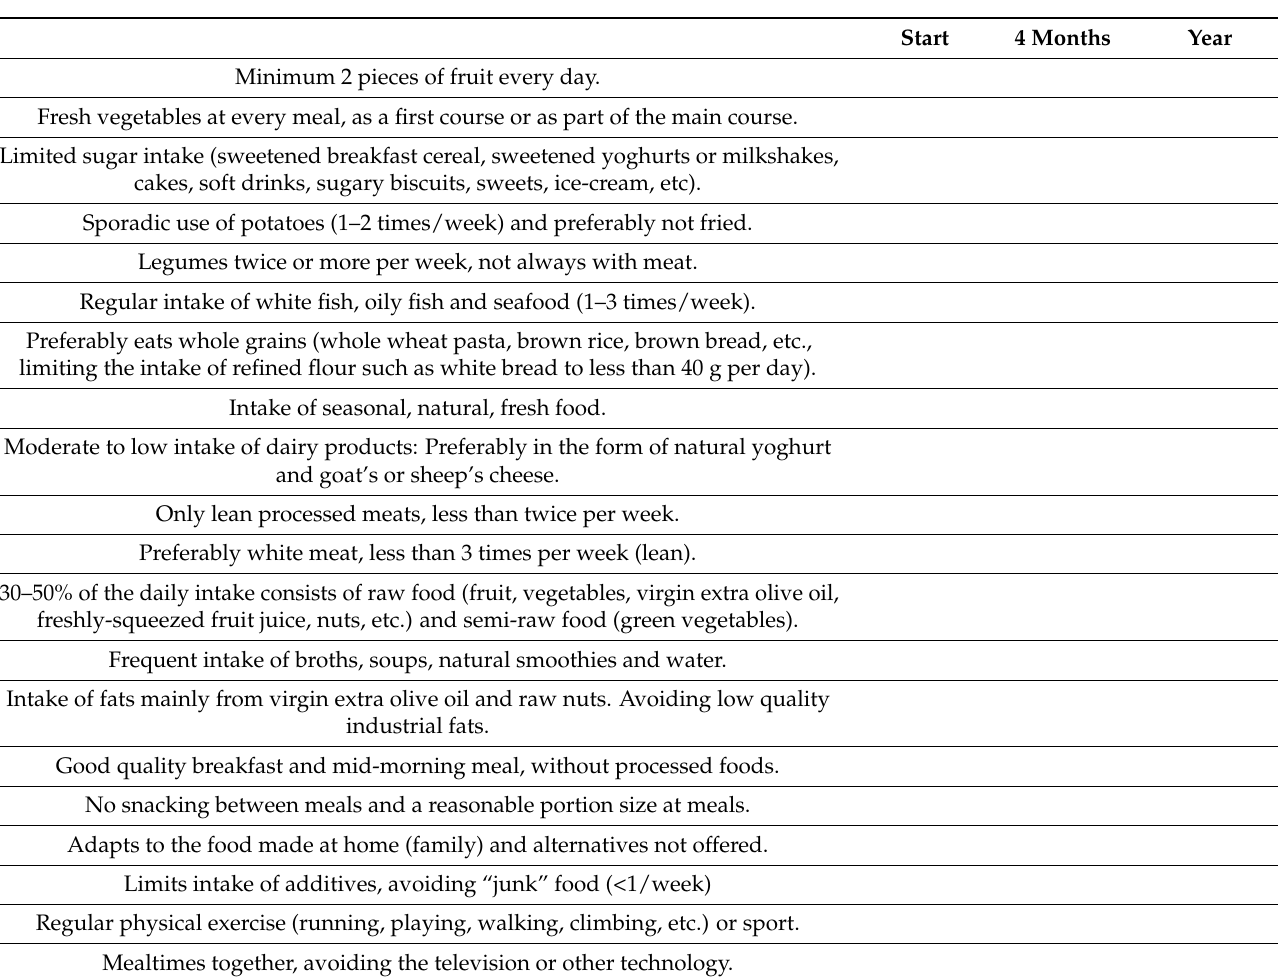
Start 4 Months Year